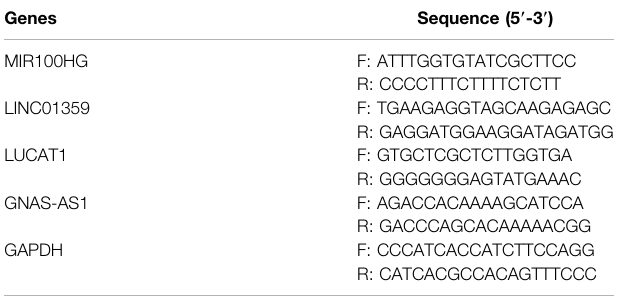
TABLE 2 | The primers for